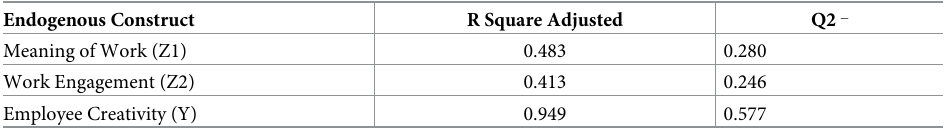
Table 5. Coefficient of determination and Q-Square.